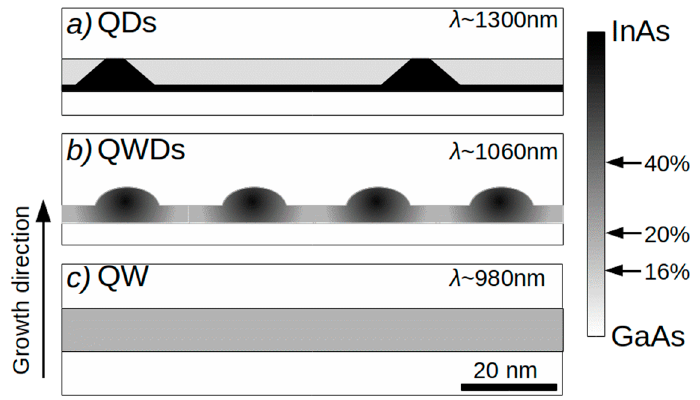
Figure 1. Schematic representation of InGaAs structures of different dimensionalities—self-organized Stranski–Krastanow quantum dots, QDs ( a ); quantum well-dots, QWDs ( b ); and quantum wells, QW ( c ).